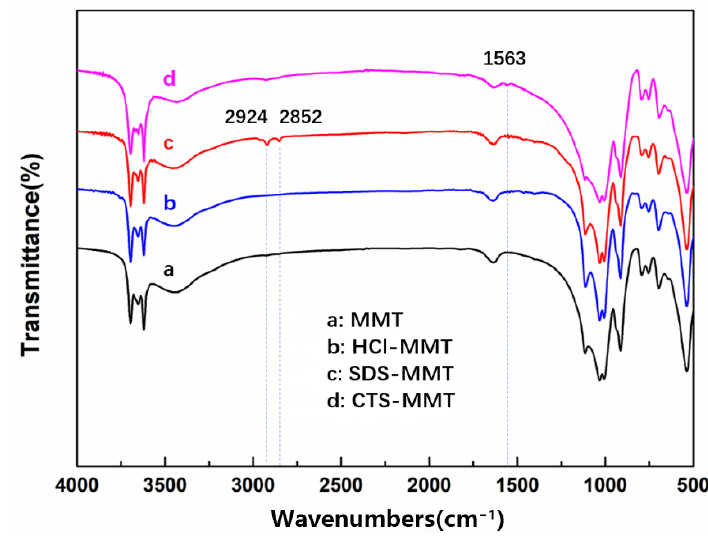
Figure 6. Infrared spectra of MMT and modified MMT.